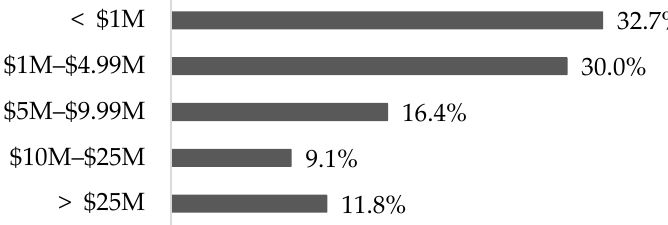
Figure 5. Maintenance budget of participants’ FM departments in US dollars.